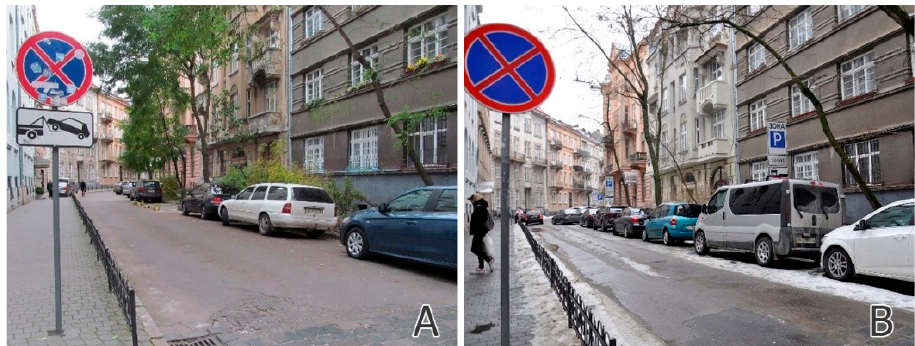
Figure 11. ( A ) On-street parking on Stetska Street. Non-arranged parking, but without violation of traffic rules (2016). ( B ) Paid on-street parking in the same place (2021). Photo by R. Liubytskyi.